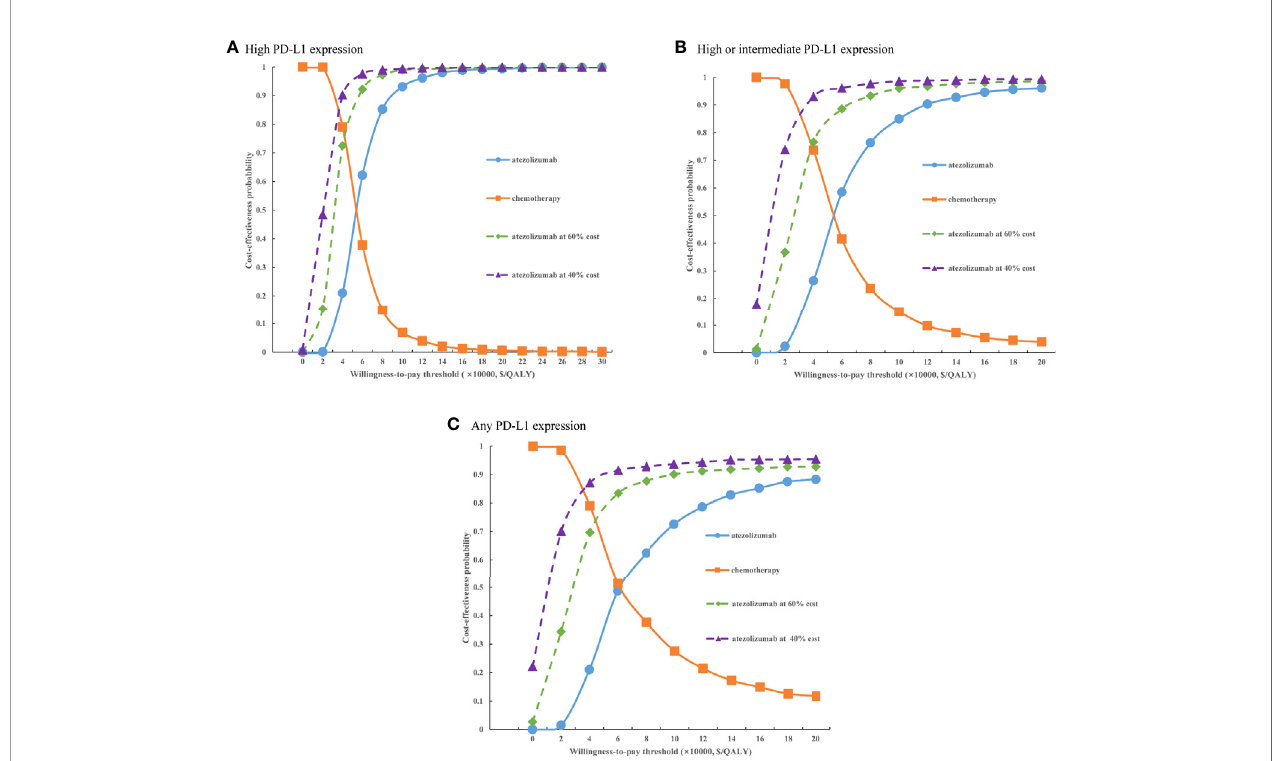
FIGURE 6 | Cost-effectiveness acceptability curves of atezolizumab versus chemotherapy when the PAP was available for (A) high PD-L1 expression populations, (B) high or intermediate PD-L1 expression populations and (C) any PD-L1 expression populations. PD-L1, programmed death ligand